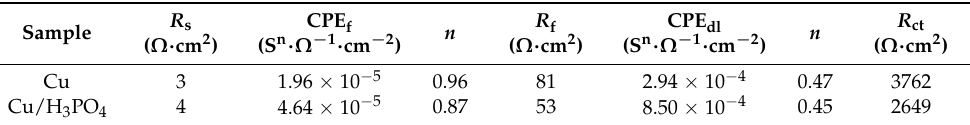
Table 3. Electrochemical impedance parameters of copper electrode with and without H 3 PO 4 solution treatment.